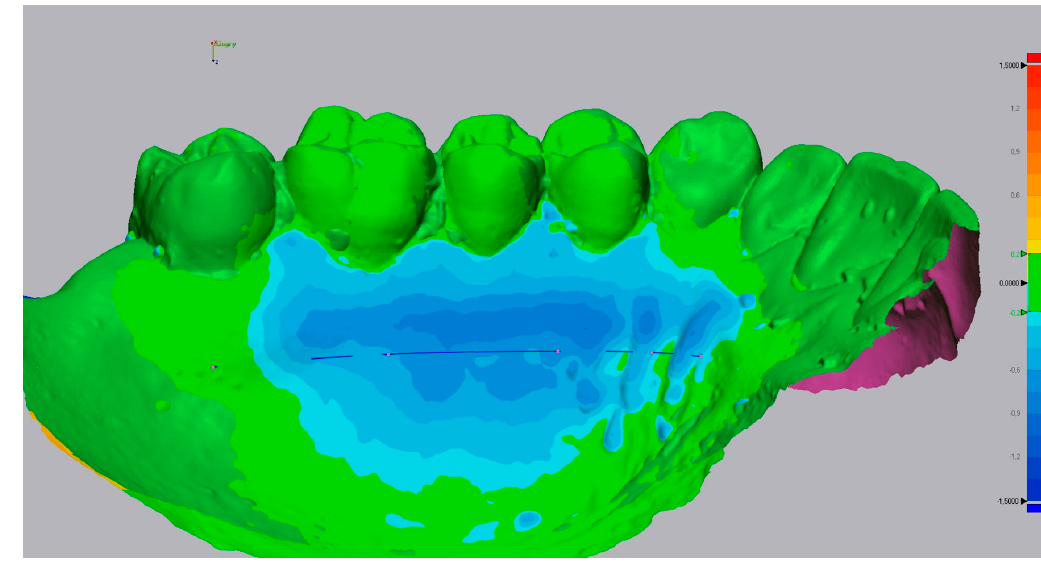
Figure 2. Insertion of a sagittal section line.